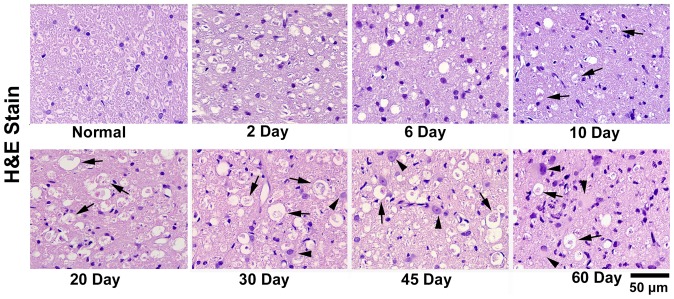
H&E stained histological images of cat's pons.The H&E images of normal side and the degenerated side of pons at 2nd, 6th, 10th, 20th, 30th, 45th and 60th day after modeling were displayed. Black arrows indicated the activated microglias, and the black arrow heads labeled the reactive astrocytes. Microgliosis emerged at 10th day after modeling, while marked astrocytosis started at 45th day after modeling. Scale bar, 50 µm.